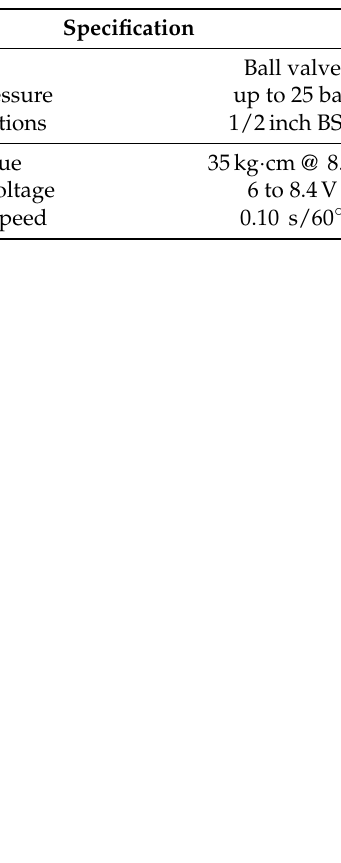
Figure 3. Flow control valve. Table 3. Specifications of flow control valve components.